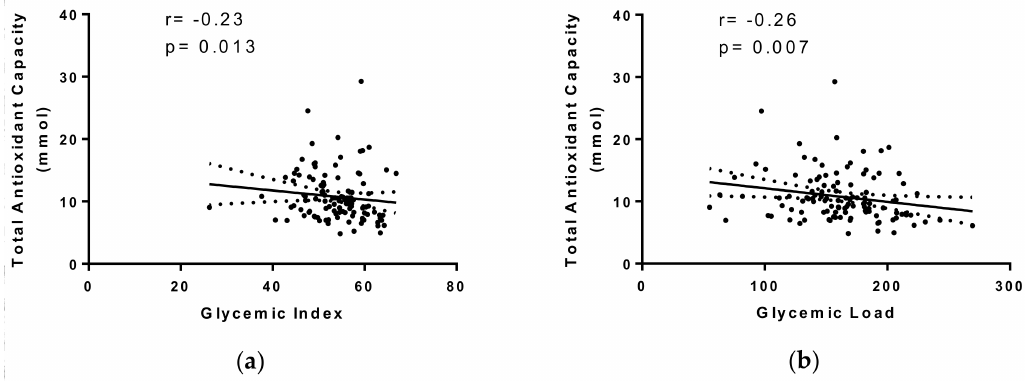
Figure 1. ( a ) Partial correlation between TAC and glycemic index (GI) adjusted by age, sex, BMI, and total energy intake. ( b ) Partial correlations between TAC and glycemic load (GL) adjusted by age, sex, BMI, and total energy intake.